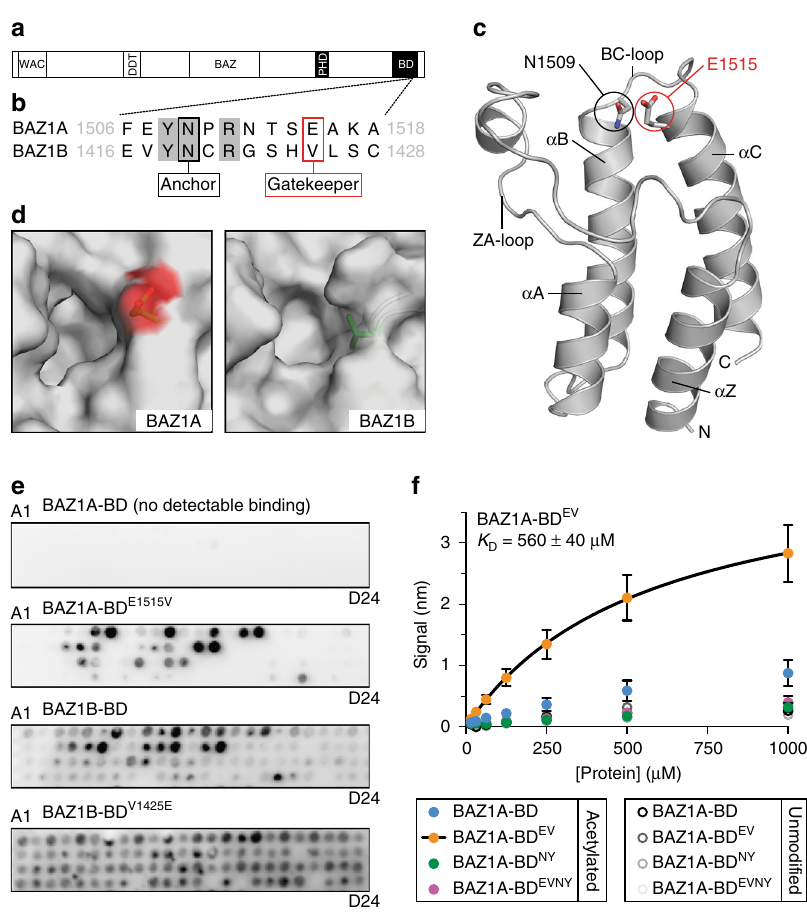
Fig. 3 A non-canonical glutamic acid “ gatekeeper ” residue reduces the af fi nity of BAZ1A-BD for acetylated histone peptides. a Schematic representation of the BAZ1A and BAZ1B proteins. b Sequence of BAZ1A-BD and BAZ1B-BD surrounding the “ anchor ” and the “ gatekeeper ” residues; amino-acid boundaries are indicated. c Cartoon representation of BAZ1A-BD from the 1.7 Å resolution crystal structure (Table 1). d Top view of the binding pockets of BAZ1A-BD and BAZ1B-BD (model) in surface representation. The side chains of the gatekeeper residues are shown in stick representation with carbon atoms colored green and the oxygen atoms of the negatively charged BAZ1A-BD E1515 shown in red . e Representative examples of histone peptide array binding images for BAZ1A-BD, BAZ1A-BD E1515V , BAZ1B-BD, and BAZ1B-BD V1425E protein modules. Refer to Supplementary Fig. 3c, d for peptide array information. f Biolayer interferometry binding study of wild-type BAZ1A-BD, BAZ1A-BD E1515V (BD EV ), BAZ1A-BD N1509Y (BD NY ), or the double mutant BAZ1A-BD E1515V/ N1509Y (BD EVNY ). Steady-state binding was determined using biotinylated histone H4 1 – 19, either with or without acetylation of the four lysines present (see “ Methods ” ). Each data point is the mean value ± s.e.m from four independent experiments. The fi tted K D for BAZ1A-BD E1515V was determined